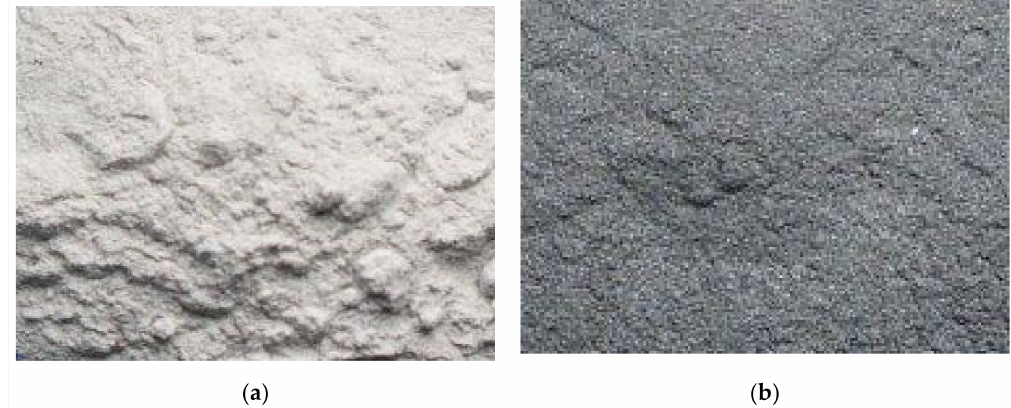
Figure 2. ZrO 2 obtained as a sludge during leaching of waste from the plasma treatment of metal surfaces ( a ) and Ni–P–ZrO 2 composite powder after the electrodeposition process ( b